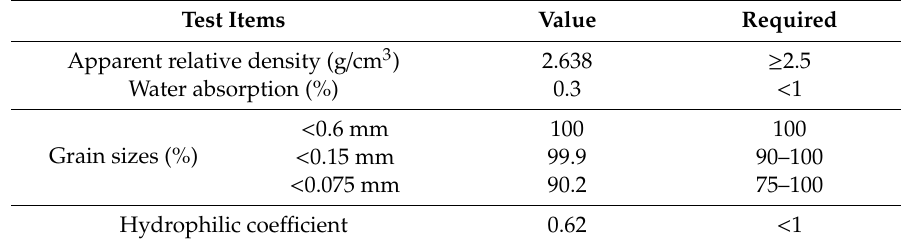
Table 4. Physical Properties of Mineral Filler.